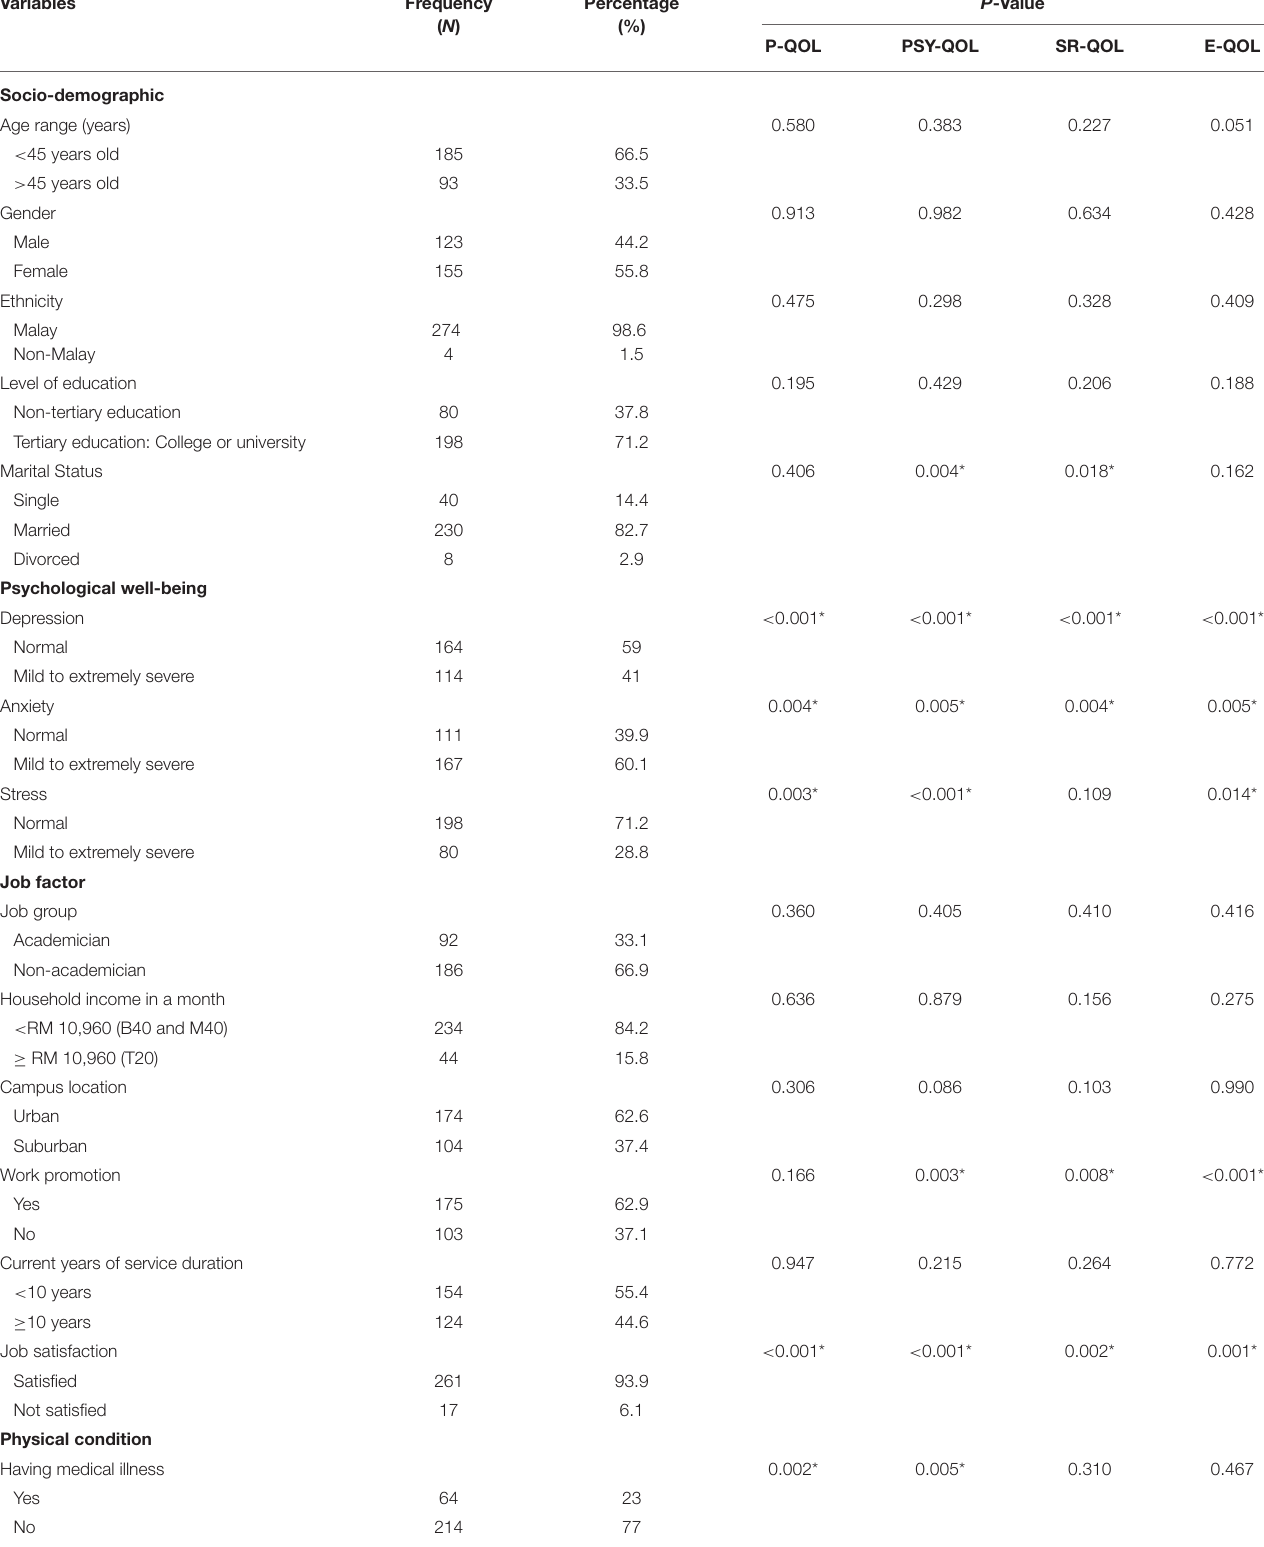
TABLE 1 | Sociodemographic, job factor, psychological well-being, physical condition and family characteristics of the participants.